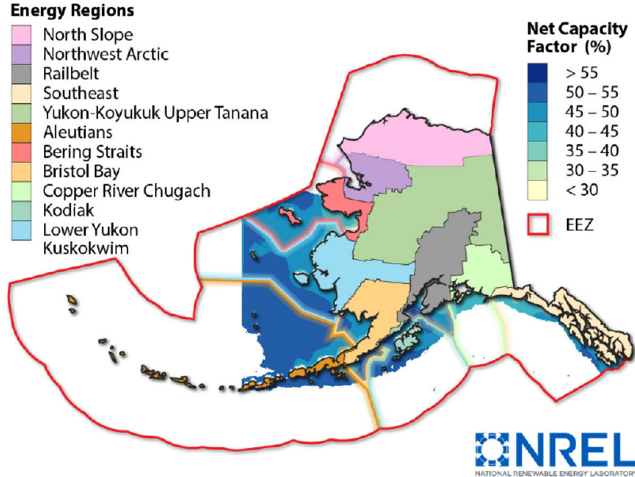
Figure 5. Offshore net capacity factor (shaded) in the technical resource area, with energy region boundaries also drawn. From Figure 16 in [9]. boundaries also drawn. From Figure 16 in [9].